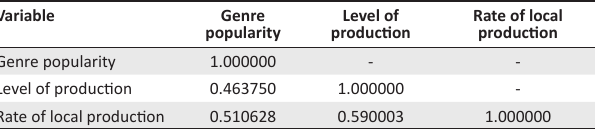
TABLE 3: The Fornell–Larcker criterion analysis for checking discriminant validity. Variable